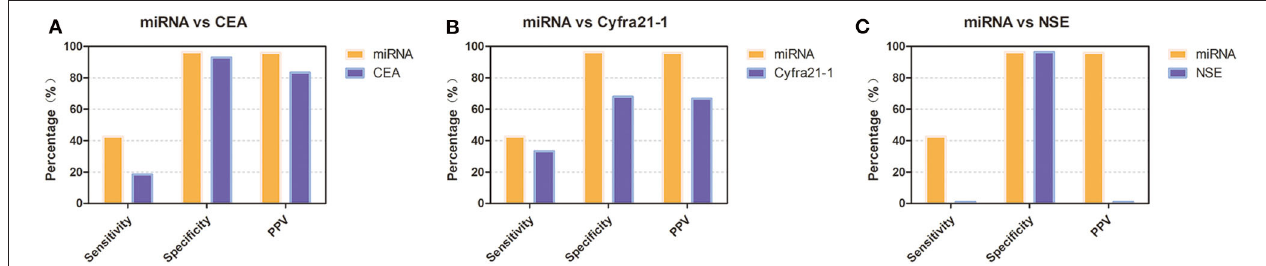
FIGURE 3 | Diagnostic performance of the 12-miRNA panel compared with that of traditional tumor markers in the validation group. (A) Diagnostic performance of the 12-miRNA panel compared with that of CEA. (B) Diagnostic performance of the 12-miRNA panel compared with that of Cyfra21-1. (C) . Diagnostic performance of the 12-miRNA panel compared with that of NSE. CEA , carcinoembryonic antigen; NSE , neuron-specific enolase; PPV , positive predictive value; miRNA, microRNA; Cyfra21-1, cytokeratin 19 fragment 21-1.